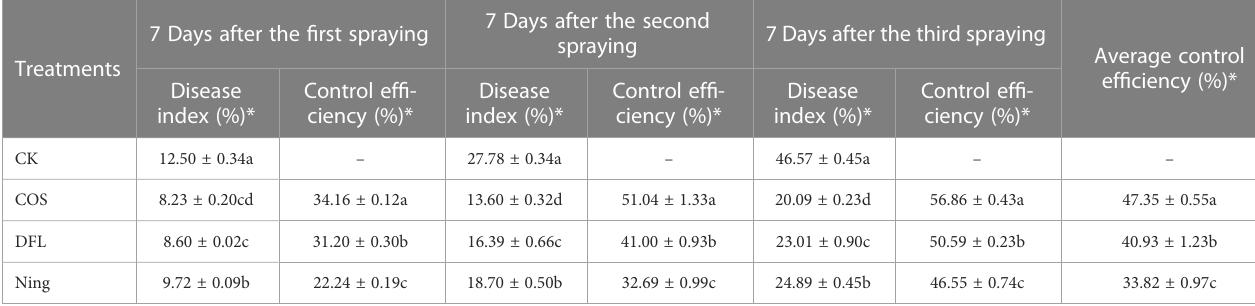
TABLE 2 The control ef fi ciencies of COS, DFL, and Ning against Passi fl ora spp. CMV disease. Treatments